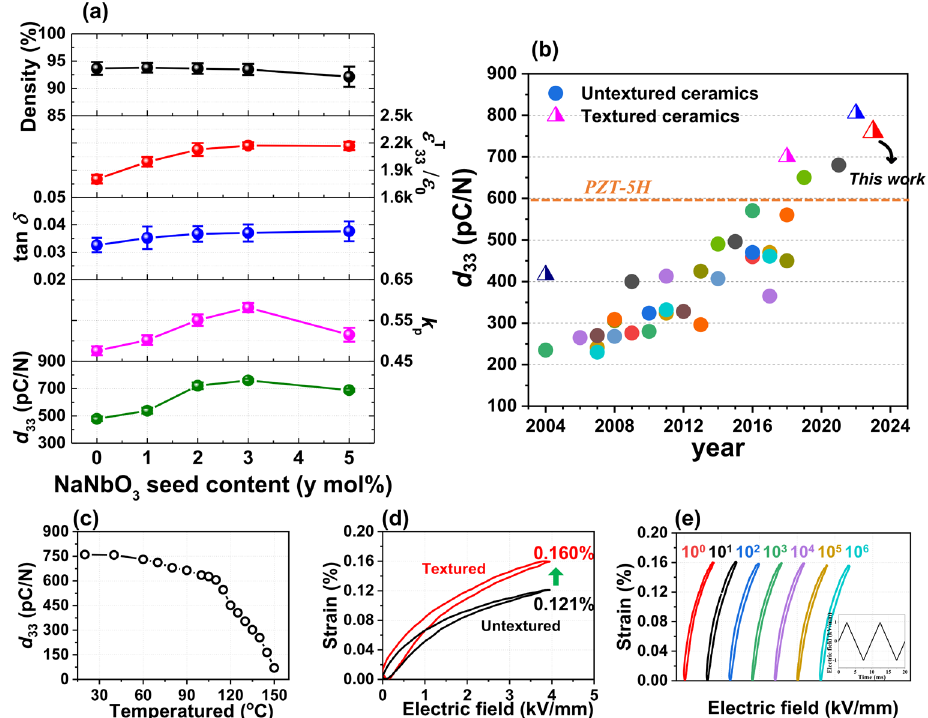
Figure 4. ( a ) Relative densities, ε T33 / ε 0 , tan δ , k p , and d 33 values of the NKNS-0.02SZ-0.02BAZ + y mol% NN thick films (0.0 ≤ y ≤ 5.0). ( b ) d 33 values of NKN-based lead-free piezoceramics reported in the literature. ( c ) The d 33 values measured at various temperatures for the thick film with y = 3.0. ( d ) Unipolar S-E curves obtained for the thick films with y = 0.0 and y = 3.0. ( e ) Unipolar S-E curves obtained for the thick film with y = 3.0 measured after the application of the electric field cycles.